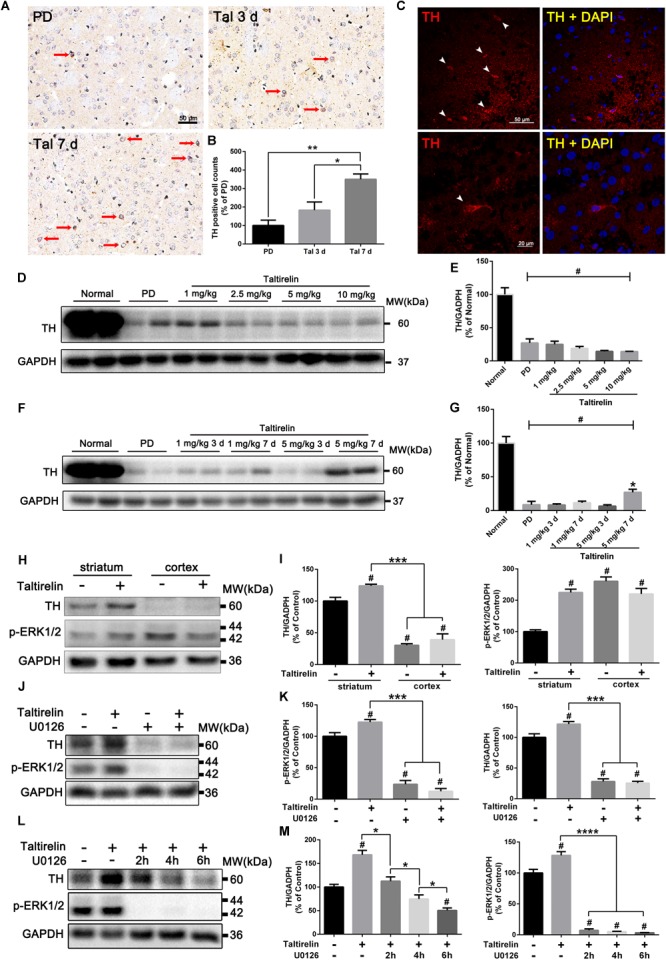
Taltirelin elevated the level of TH both in vivo and in vitro in a p-ERK/1/2-dependent manner. (A) Immunostaining of tyrosine hydroxylase (TH) in the lesioned striatum of each group (PD, Tal 5 mg/kg for 3 days or 7 days). Red arrows indicated TH-positive cells. (B) Counts of TH-positive cells. (C) Immunofluorescent staining of TH in the lesioned striatum of animals treated with Tal 5 mg/kg for 7 days. White arrows indicated TH-positive cells (top). Higher-magnification photomicrographs of a TH-positive cell (down). (D,E) Western blot analysis of TH in the lesioned striatum of each group (normal, PD, Tal 1, 2.5, 5, or 10 mg/kg). (F,G) Western blot analysis of TH in the lesioned striatum of each group (normal, PD, Tal 1 or 5 mg/kg continuous administrated for 3 or 7 days). (H,I) Western blot analysis of intracellular TH and p-ERK1/2 of the primary rat striatal or cortical neurons treated with Tal 1, 5, or 10 μM. (J,K) Western blot analysis of intracellular TH and p-ERK1/2 of the primary rat striatal neurons pre-treated with MEK inhibitor U0126 (10 μM) for 2 h, then incubated with Tal (5 μM) for 24 h. (L,M) Western blot analysis of intracellular TH and p-ERK1/2 of the primary rat striatal neurons incubated with Tal (5 μM) for 24 h, then treated with U0126 (10 μM) for 2 h, 4 h, or 6 h. #p < 0.01 vs. normal or control; ∗p < 0.05; ∗∗p < 0.01; ∗∗∗p < 0.001; ∗∗∗∗p < 0.0001. N = 3. Error bars represent SEM.